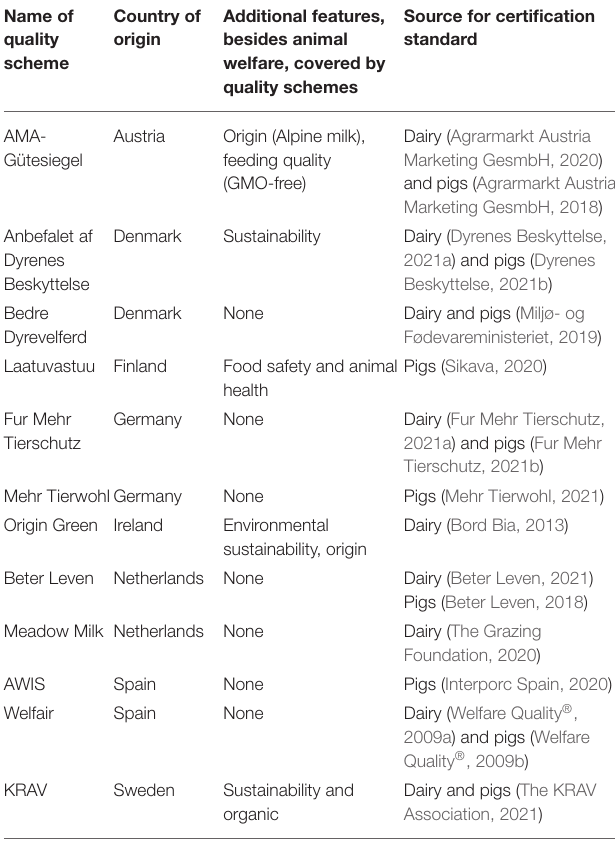
TABLE 1 | Name, origin, additional features, and source of information concerning certification standards for analyzed quality schemes. Name of